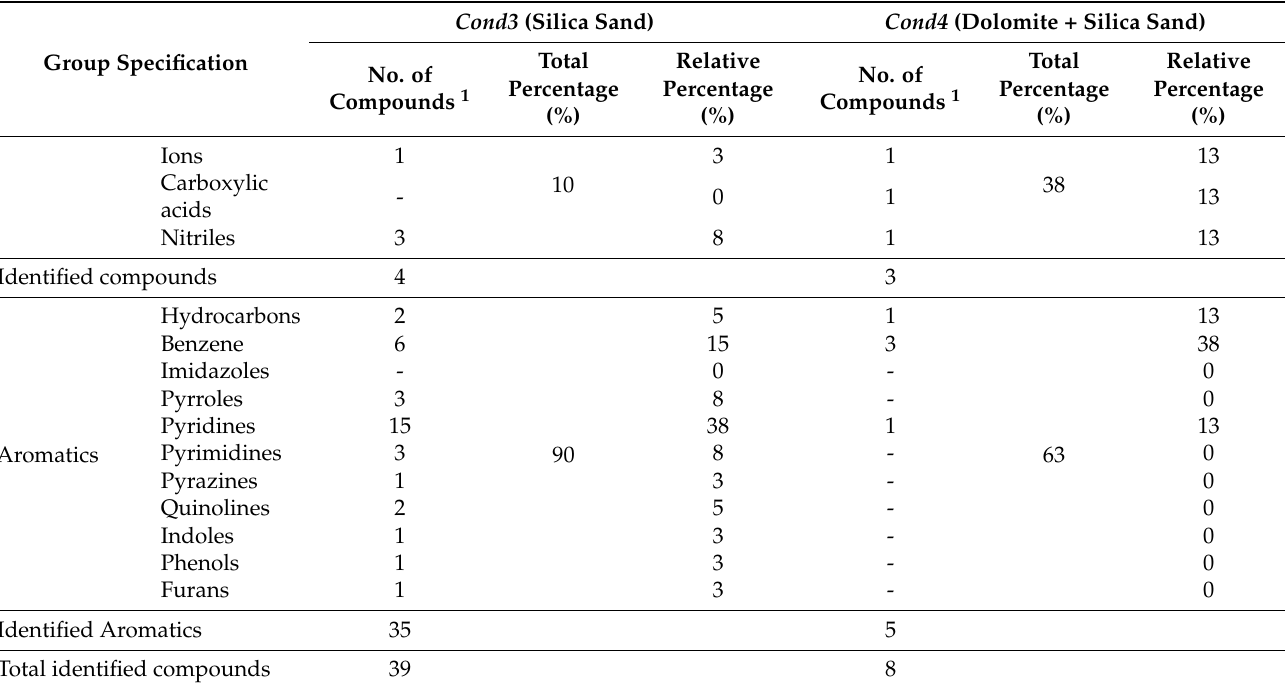
Table 6. Distribution by chemical group of the compounds identified by GC-MS in the condensates that were obtained by gasification of WST at 800 ◦ C in the presence of different catalysts. Cond3 and Cond4 gasification conditions are described in Table